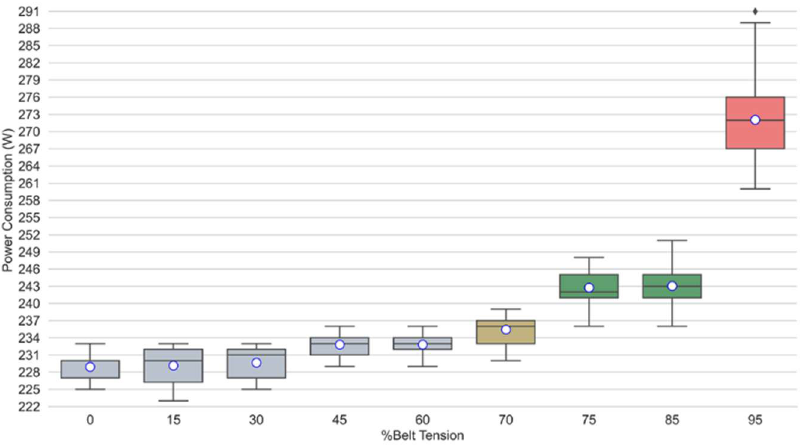
Figure 13. Power consumption of the conveyor belt motor driver for all load combinations corre-